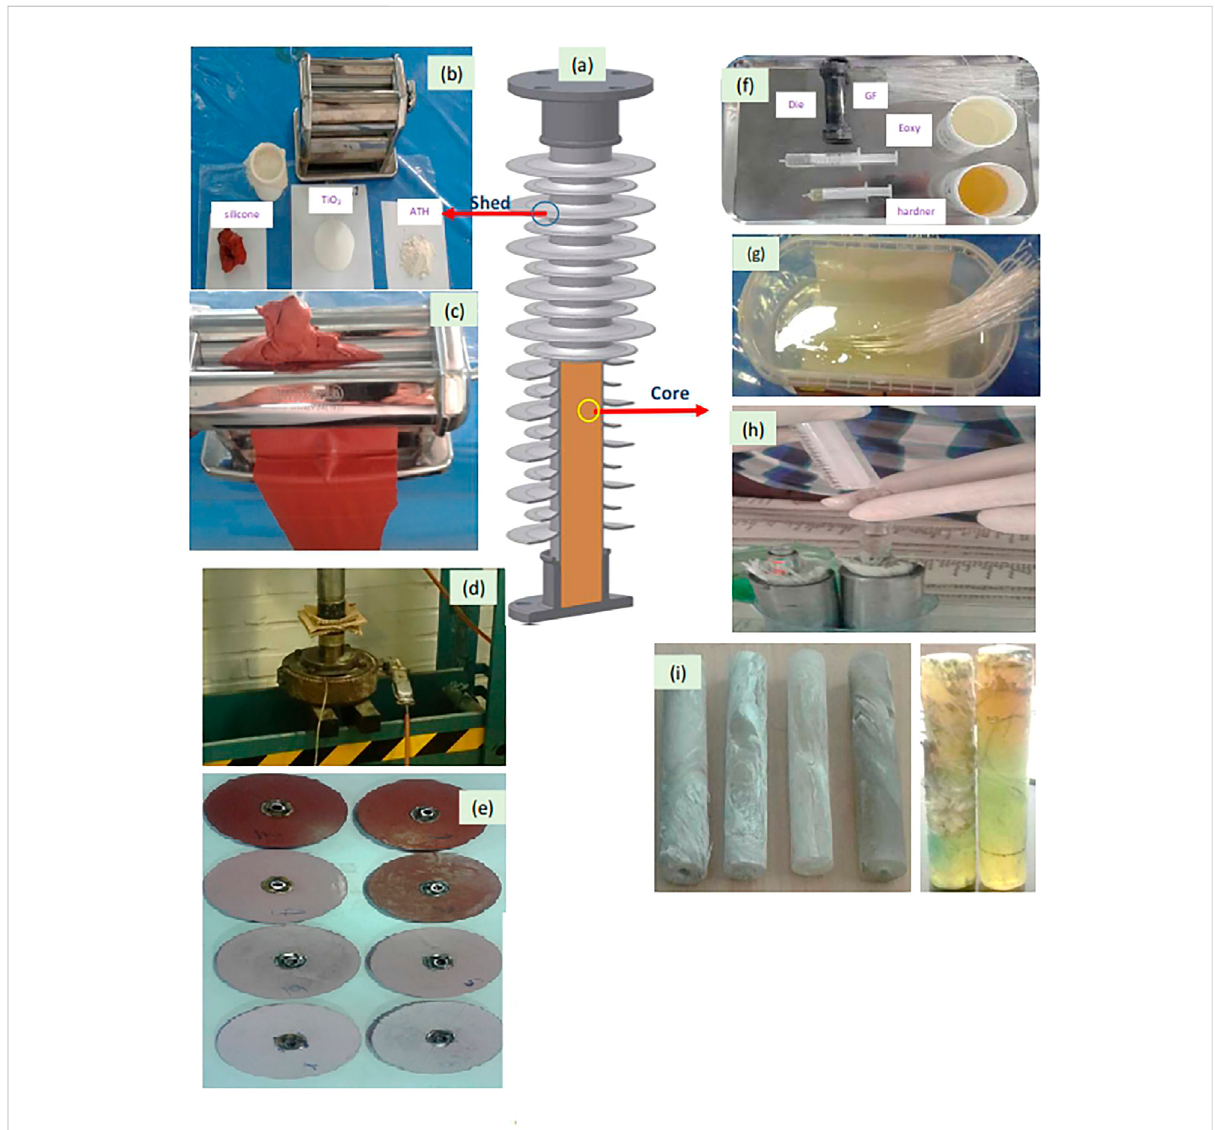
FIGURE 1 (A) Schematic of a high-voltage insulator containing the shed (left side) and core (right side). (B) Raw materials (silicone rubber, TiO 2 , and ATH powders) and roll milling apparatus. (C) Roll milling of the raw materials to produce the paste. (D) Hot pressing the paste. (E) Samples